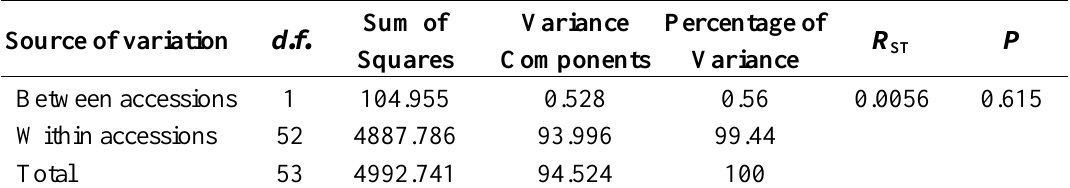
Table 3. Analysis of molecular variance (AMOVA) between the cultivar accession and the Taiwan accession. The variance explained by differences among accessions and its significance were calculated using probabilities derived from 1000 permutations.